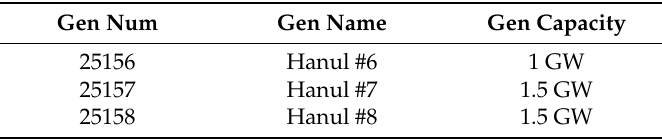
Table 3. The generators’ status-receiving SPS signal.